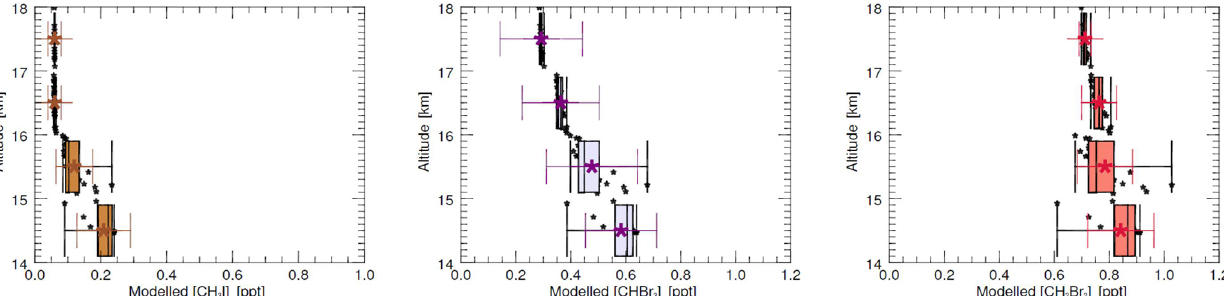
Figure 6. Vertical distribution of NAME-modelled CH 3 I, CHBr 3 and CH 2 Br 2 (sums of boundary layer and background contribution) in the TTL for research flight 02, ATTREX 2014.